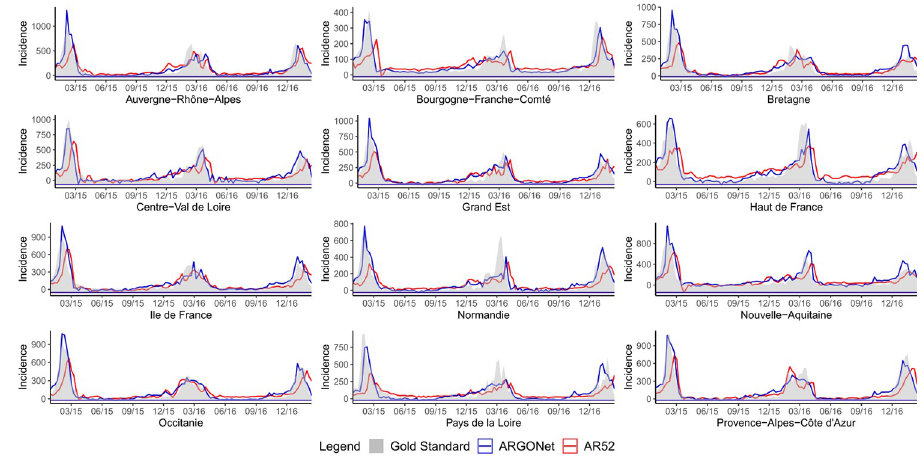
Fig 11. Nouvelle-Aquitaine one-week ahead